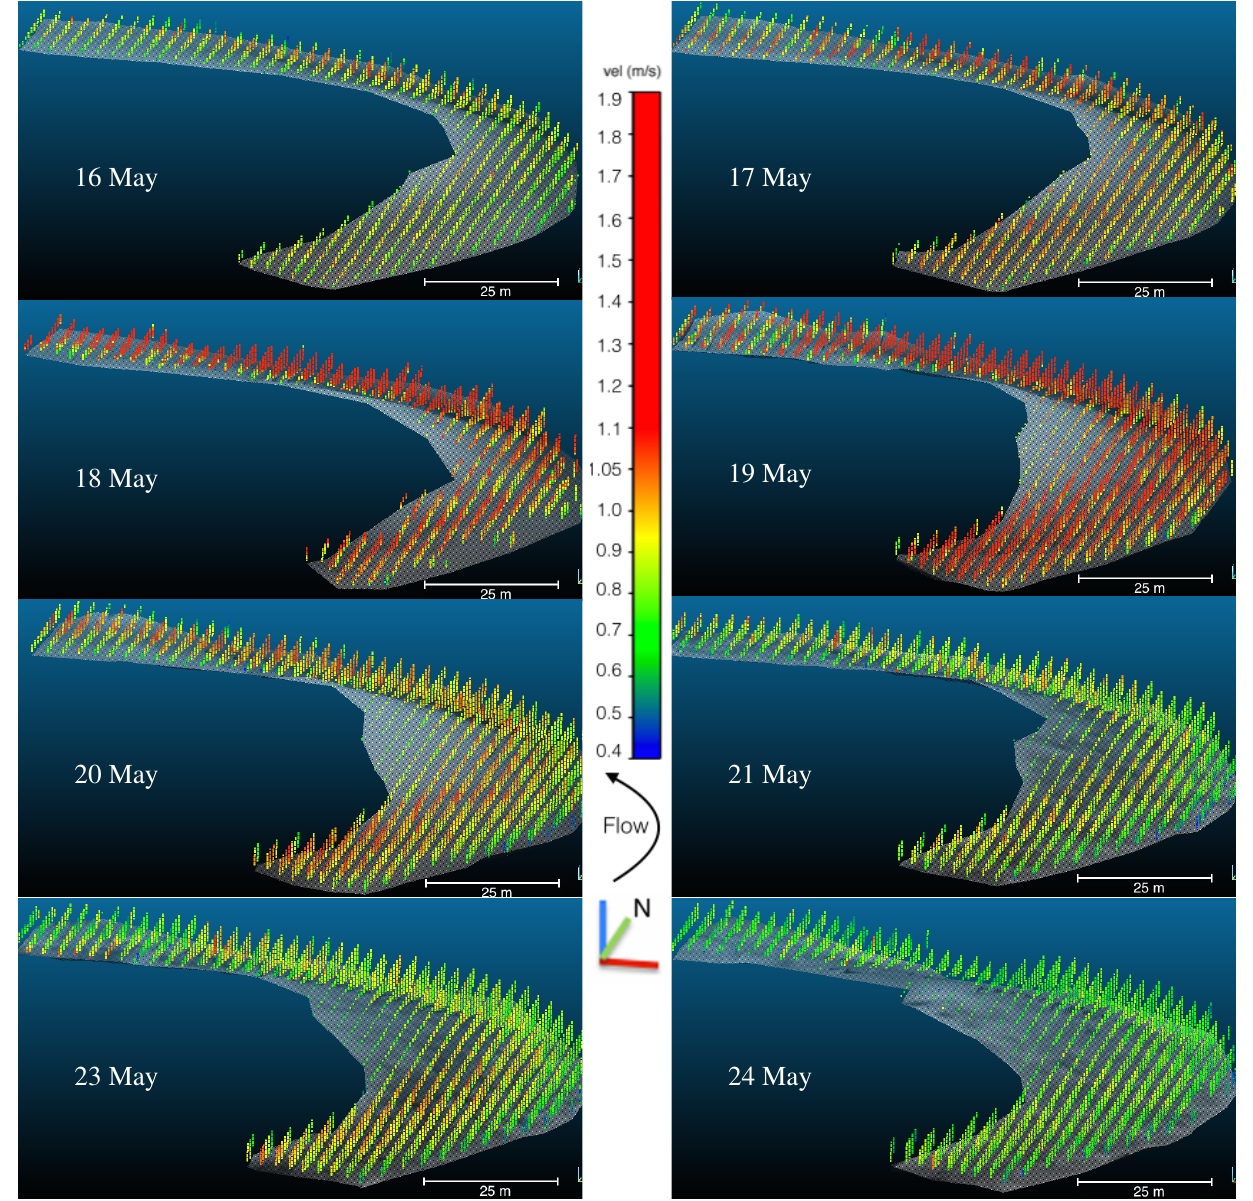
Figure 9. 3D point cloud of flow velocities colored according to velocity magnitude ( ms − 1 ). A triangulation of the river bed is included to enhance the visualization. The Z-axis is exaggerated by a factor of